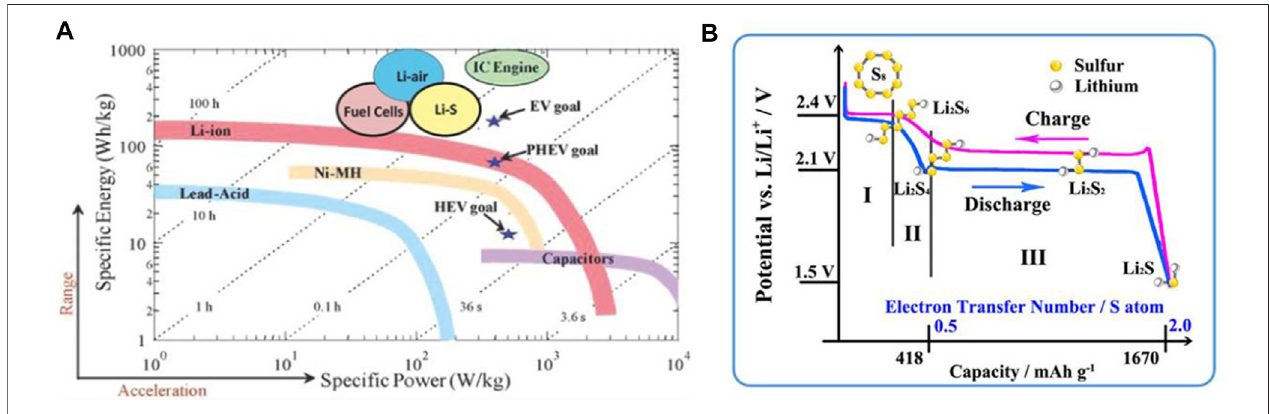
SCHEME 1 | (A) Ragone plots of typical energy storage systems. (A) Figure reproduced from the data in Rosenman et al. (2015). (B) The galvanostatic charge – discharge pro fi les of a typical Li − S battery and the corresponding products at each voltage stage. (B) Figure reproduced from data in Liang et al. (2016).